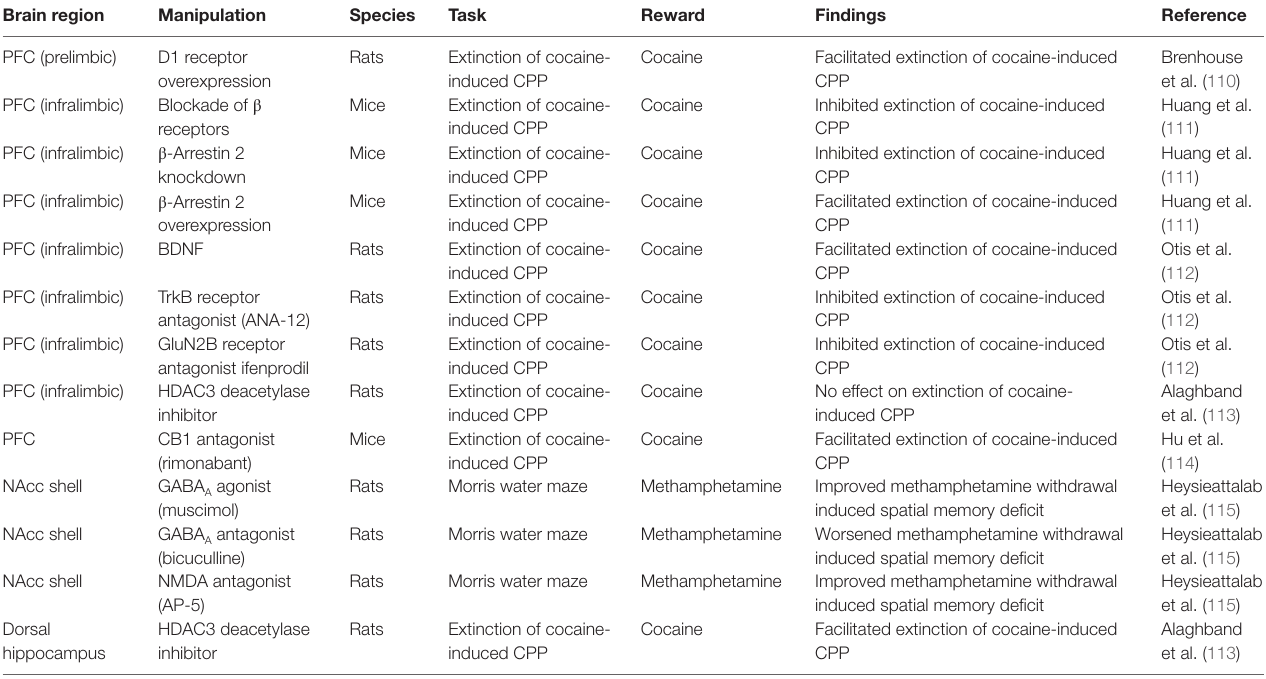
TABLE 1 | Brain region-specific manipulation on psychostimulant-induced cognitive deficits. Brain